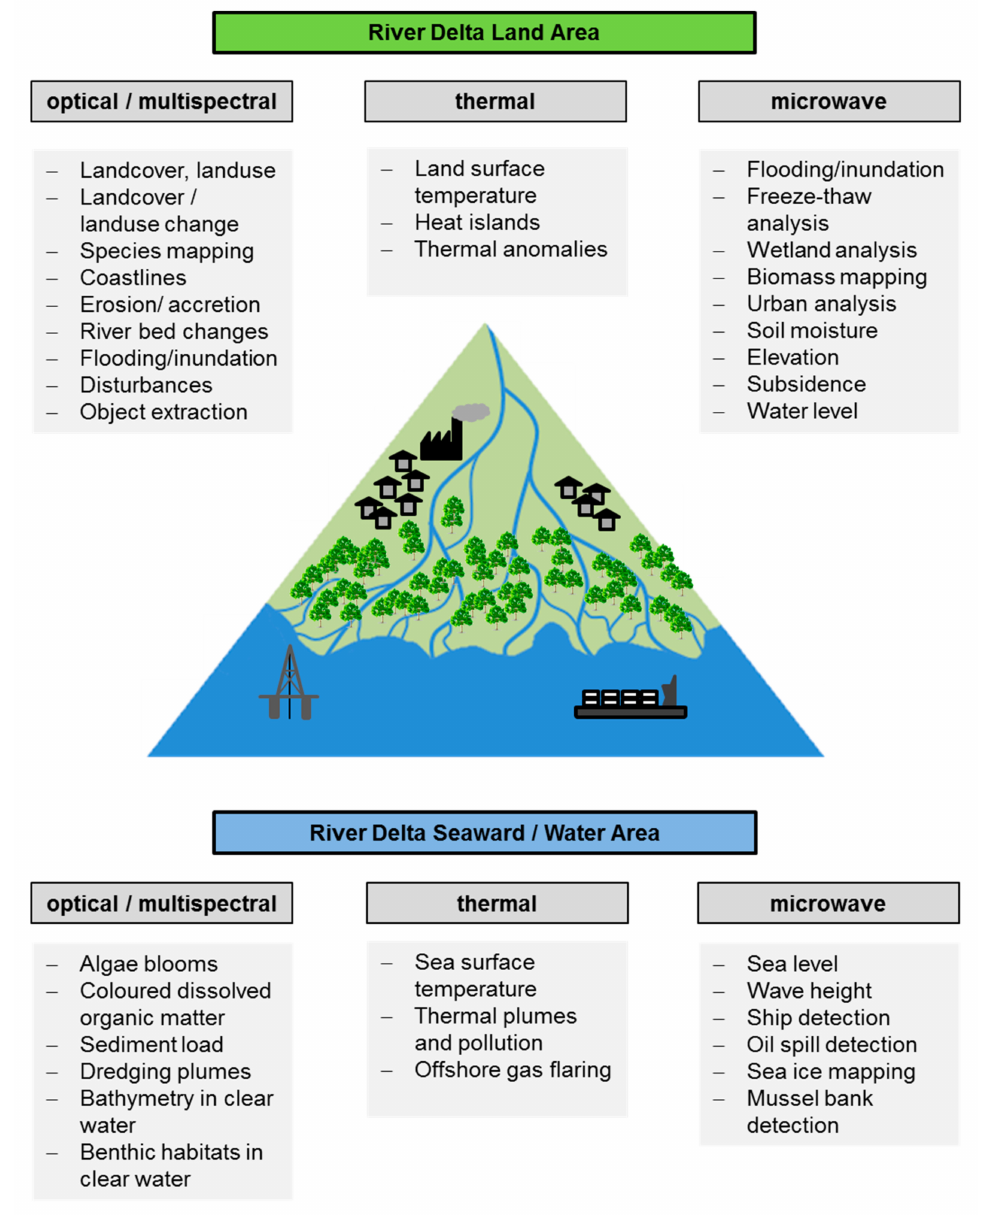
Figure 3. Remote sensing of river delta environments: land- and water-related applications and information